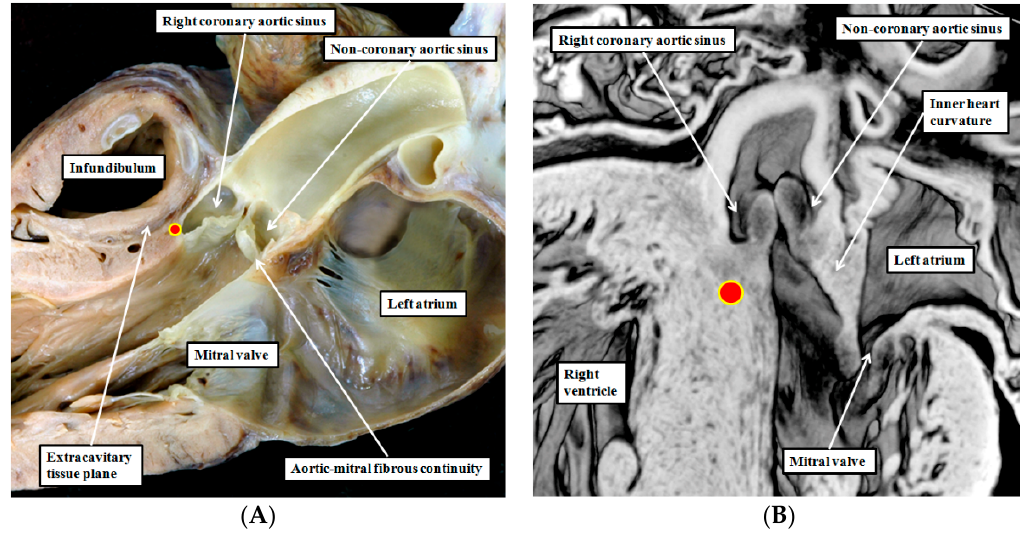
Figure 4. The left hand panel ( A ) shows the outflow tract of the normal left ventricle sectioned to replicate the so-called parasternal long axis echocardiographic plane. It shows the fibrous continuity between the aortic leaflet of the mitral valve and the non-coronary leaflet of the aortic valve. The red circle with yellow borders shows the location of the dead-end tract. Note the extracavitary tissue plane between the crest of the ventricular septum and the subpulmonary infundibulum; The right hand panel ( B ) is taken from an episcopic dataset prepared from a developing mouse embryo at E15.5. By this stage, the embryonic interventricular communication is closed, but the inner heart curvature forming the roof of the left ventricle, and interposing between the developing leaflets of the aortic and mitral valves, remains myocardial. The red circle with yellow borders again shows the location of the dead-end